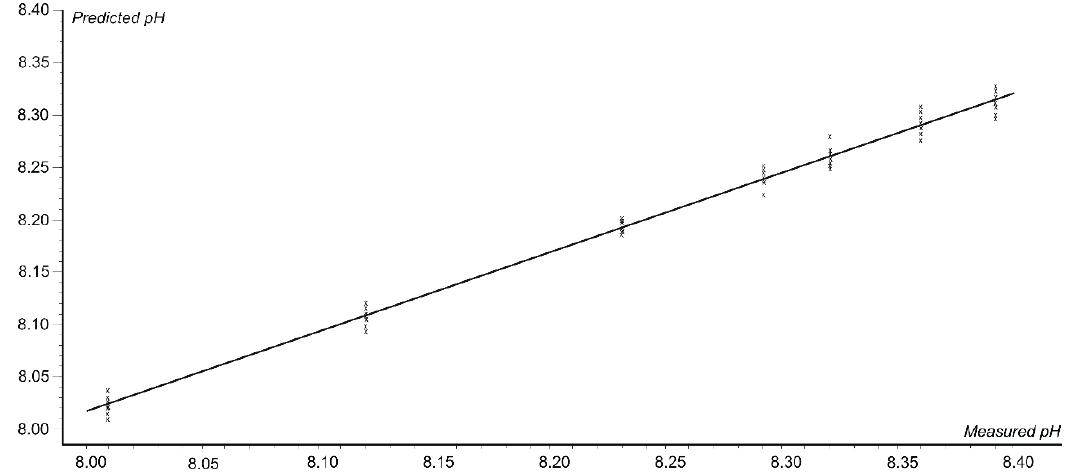
Figure 6. The graph of the correlation between the pH values predicted by the voltammetric sensors versus the values of the pH determined by the potentiometric method. Table 6. Estimated parameters from the PLS1 regression